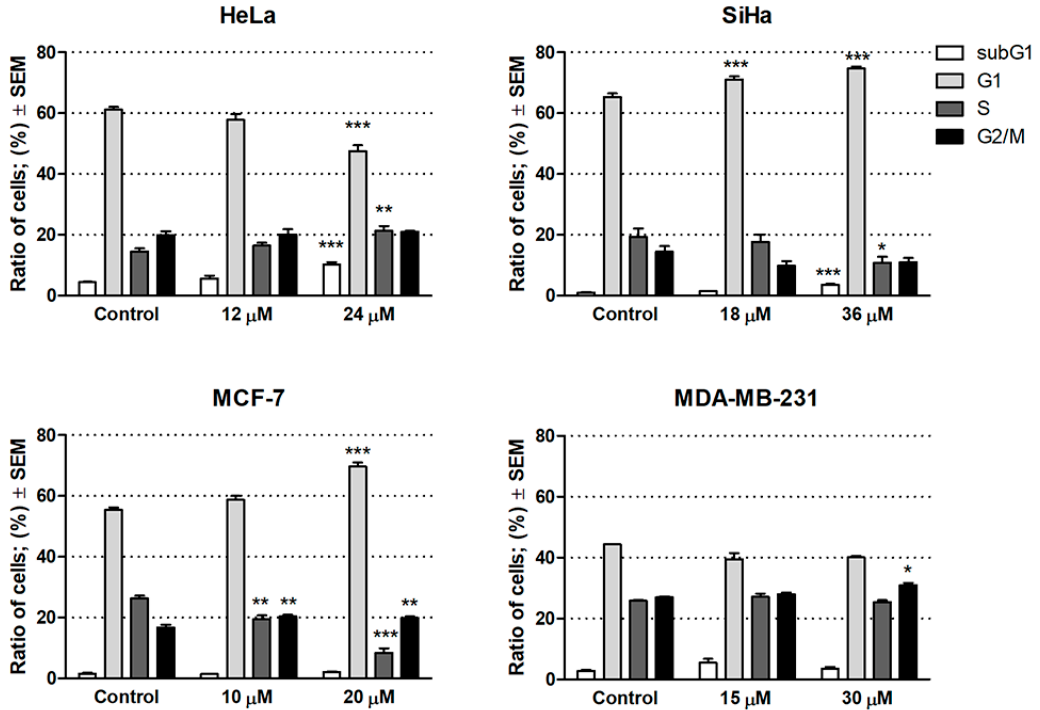
Figure 2. Cell cycle distributions of human gynecological cancer cell lines HeLa, SiHa, MCF-7 and MDA-MB-231 after treatment with compound 6 . *, ** and *** indicate p < 0.05, p < 0.01 and p < 0.001, respectively, by means of one-way ANOVA followed by Dunnett’s post-hoc test.